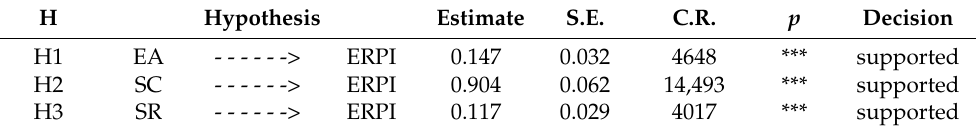
Table 8. SEM Estimates on Hypothesis Tests.